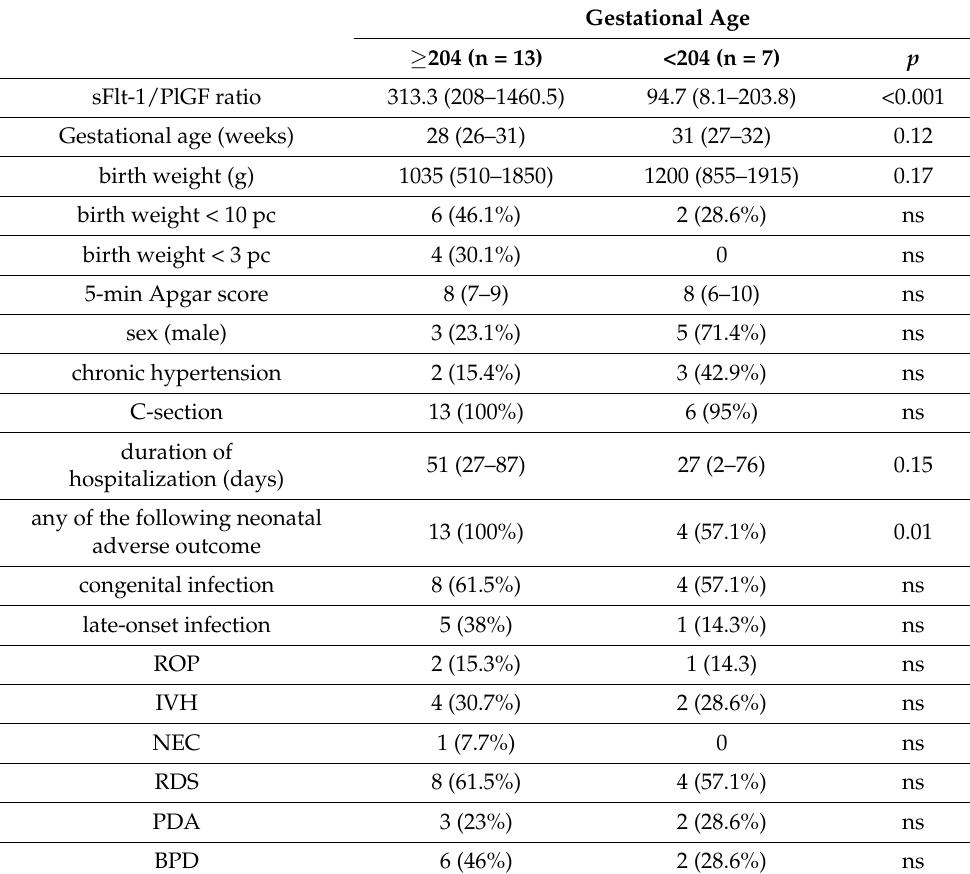
Table 4. Perinatal outcomes and neonatal complications in infants born prior to 32 wkGA divided between those below and above the sFlt-1/PlGF ratio of